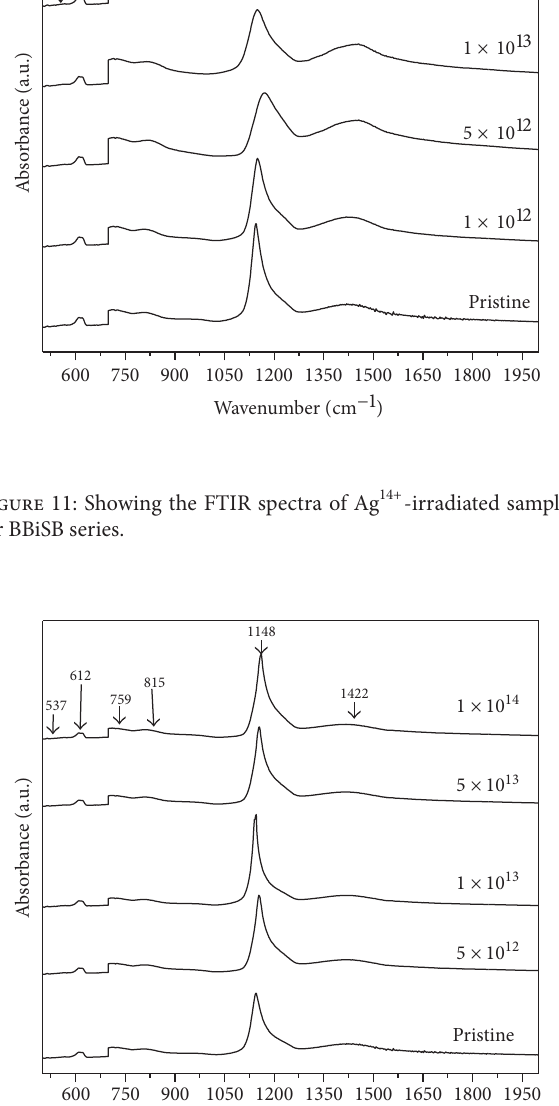
-irradiated samples for 3+